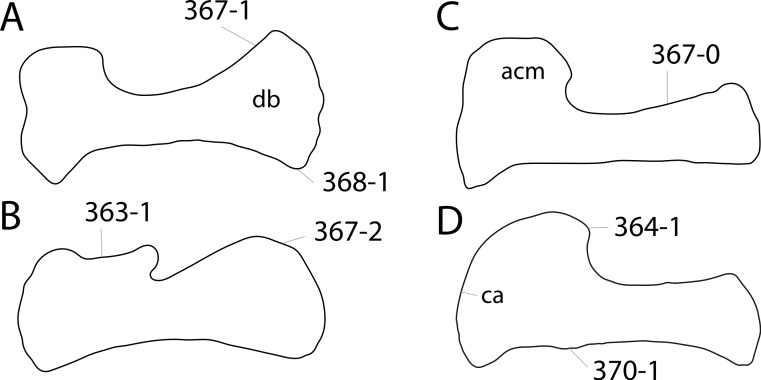
Scapula outlines of Diplodocoidea.Scapula outlines of Haplocanthosaurus priscus CM 879 (A), Limaysaurus tessonei MUCPv-205 (B), Apatosaurus louisae CM 3018 (C; all traced from Mannion, 2009), and Diplodocus hallorum AMNH 223 (D; traced from Osborn, 1899). Note the concave dorsal border of the acromion process (B; C363-1), the acromion process that reaches almost half the scapular length (D; C364-1), the different shapes of the acromial edge (straight, C, C367-0; with rounded expansion distally, A, C367-1; raquet-shaped, B, C367-2), the ventrally curving ventral margin (A; C368-1), and the subtriangular process (D; C370-1). Abb.: acm, acromion; ca, coracoid articulation; db, distal blade. Scaled to same scapular length.